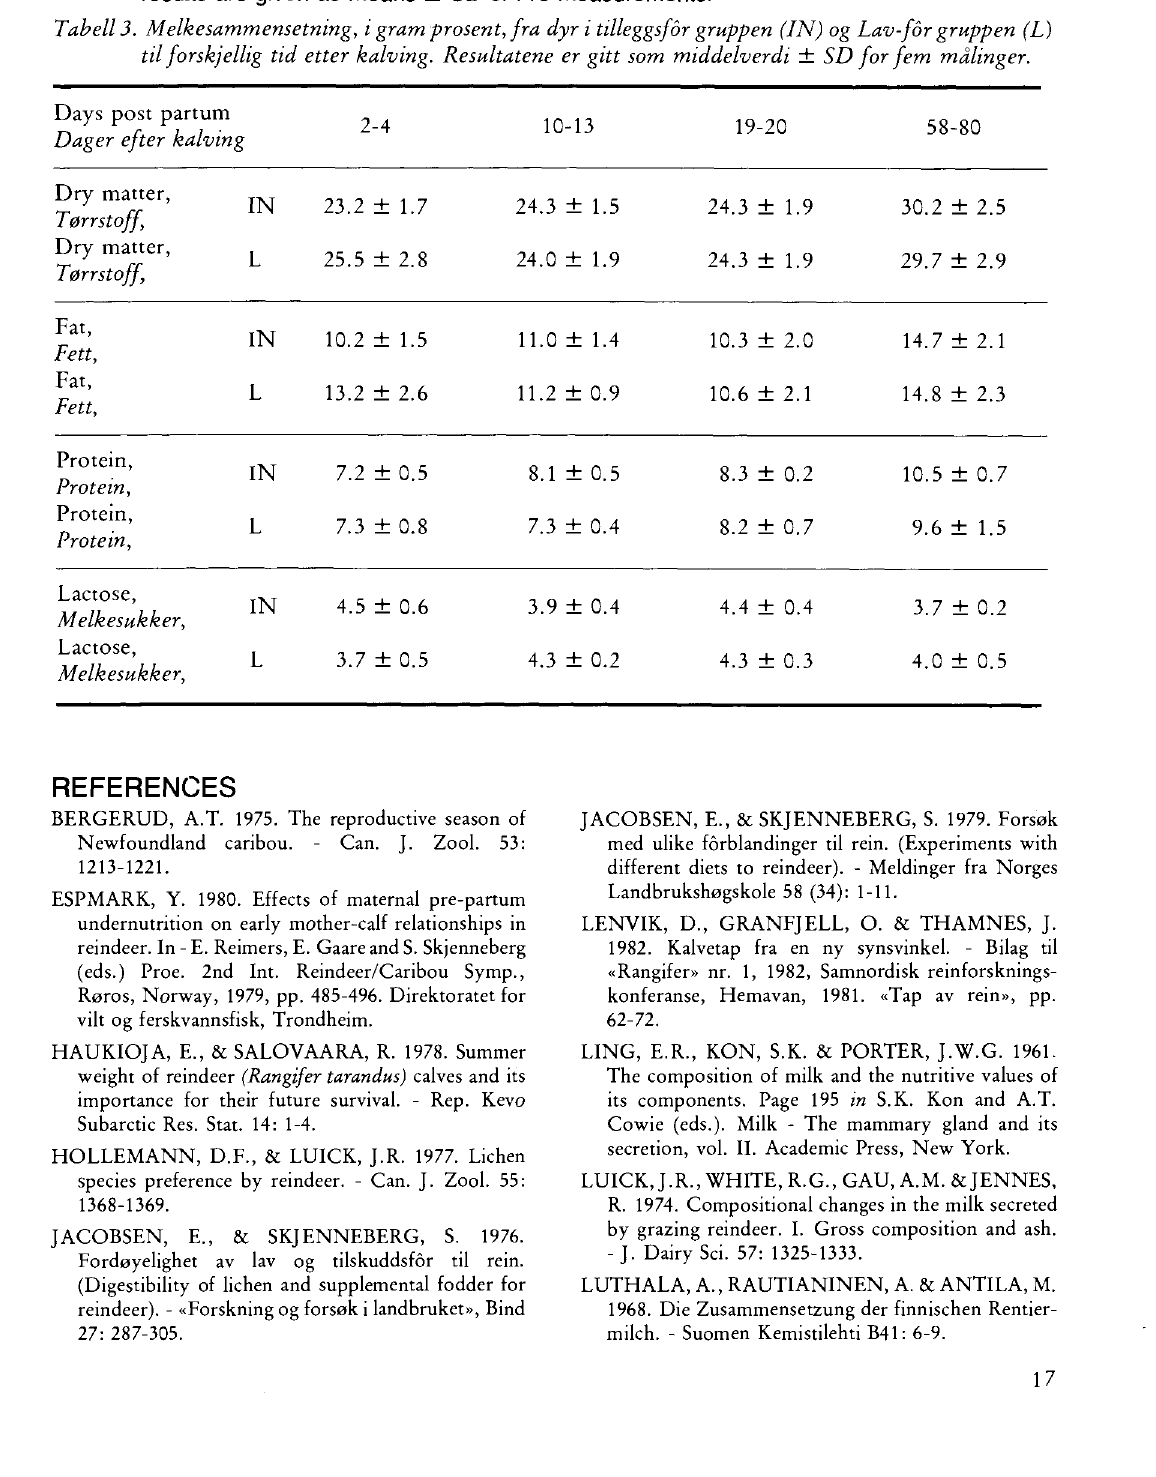
Table 3. The composition of the major constituents of milk (gram percent) from the animals in the Improved Nutrition group (IN) and the Lichen group (L) at different times post partum. The results are given as means ± SD of five